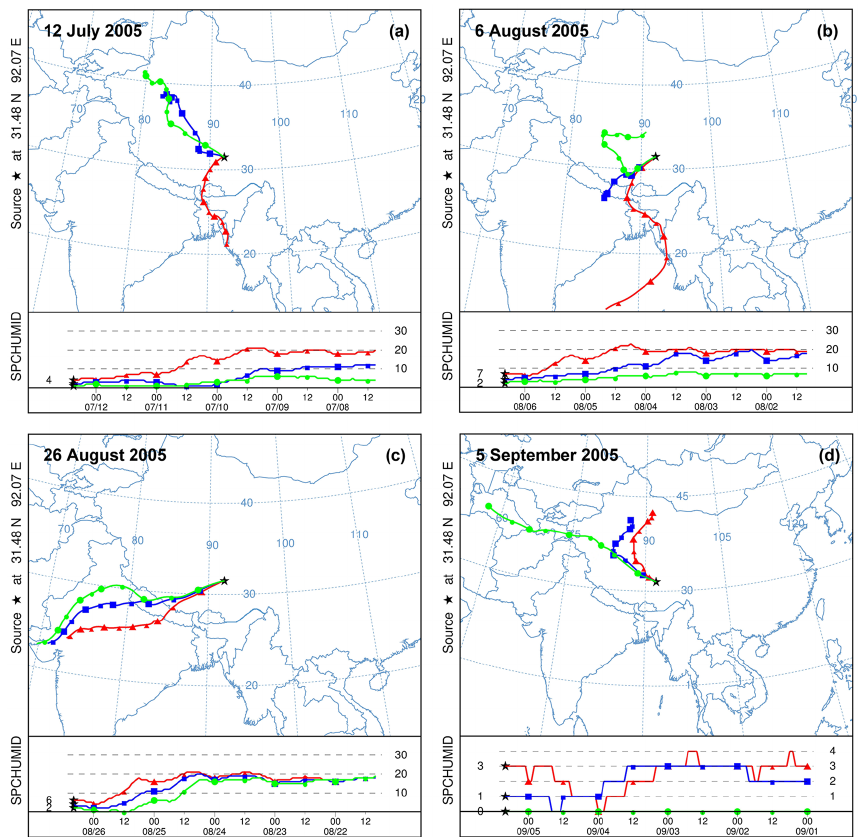
Figure 6. Back trajectories calculated by HYSPLT at 1000 (red lines), 2000 (blue lines), and 3000m (green lines) a.g.l. on 12 July, 6 August, 26 August, and 5 September 2005, representing the conditions during the weak monsoon (a) , active monsoon (b) , late monsoon (c) , and post- monsoon (d) periods, respectively, over the Nagqu station. Note that changes in specific humidity (gkg − 1 ) along the air parcel pathways are also